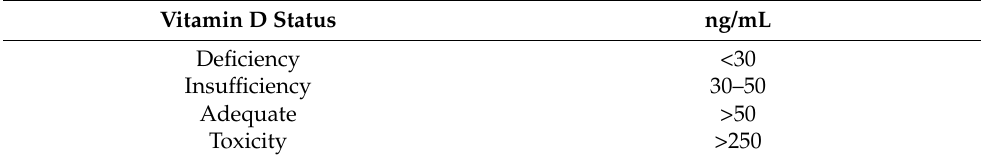
Table 2. Severity of 25(OH) vitamin D deficiency.